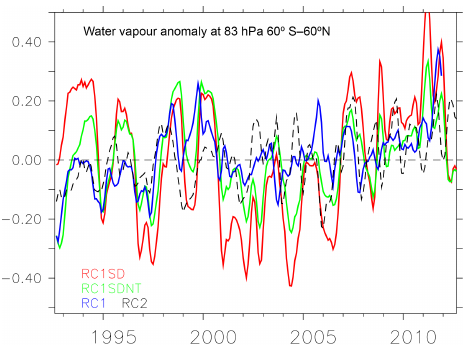
Figure 4. Near-global mean (60 ◦ S–60 ◦ N) water vapour anomalies (in ppmv) (deseasonalized; note, these anomalies are a 12-month running mean and therefore slightly different compared to RC1SD in Fig. 1) derived from RC1SD, RC1SDNT, RC1, and RC2 simula-